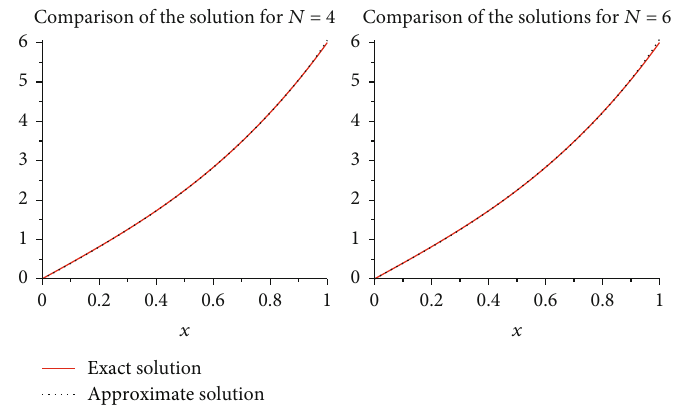
Figure 3: The comparison result of the approximate and exact solutions for Example 1 ( N = 4, 6 ). Table 2: Absolute errors obtained by proposed method with N = 6, 8 for Example 2.